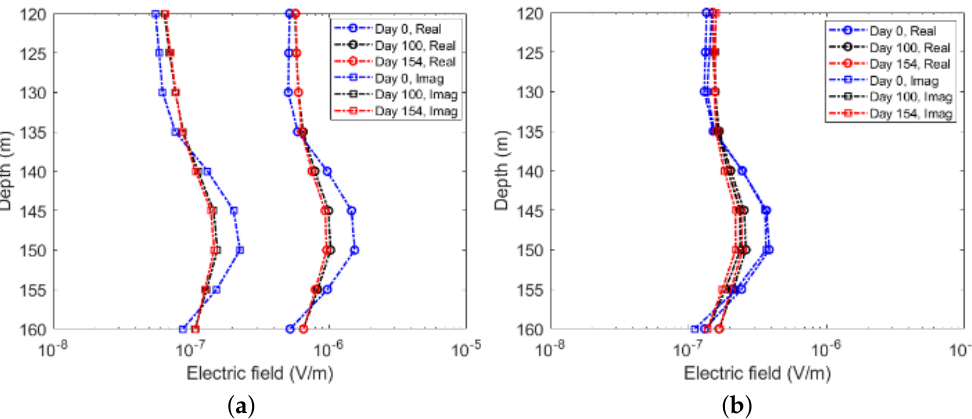
Figure 14. Electric fields from the HED source using the surface-to-borehole method at ( x , z ) = ( − 300 m, − 5 m) with two different Hz. ( a ) 10 Hz. ( b ) 100 Hz.